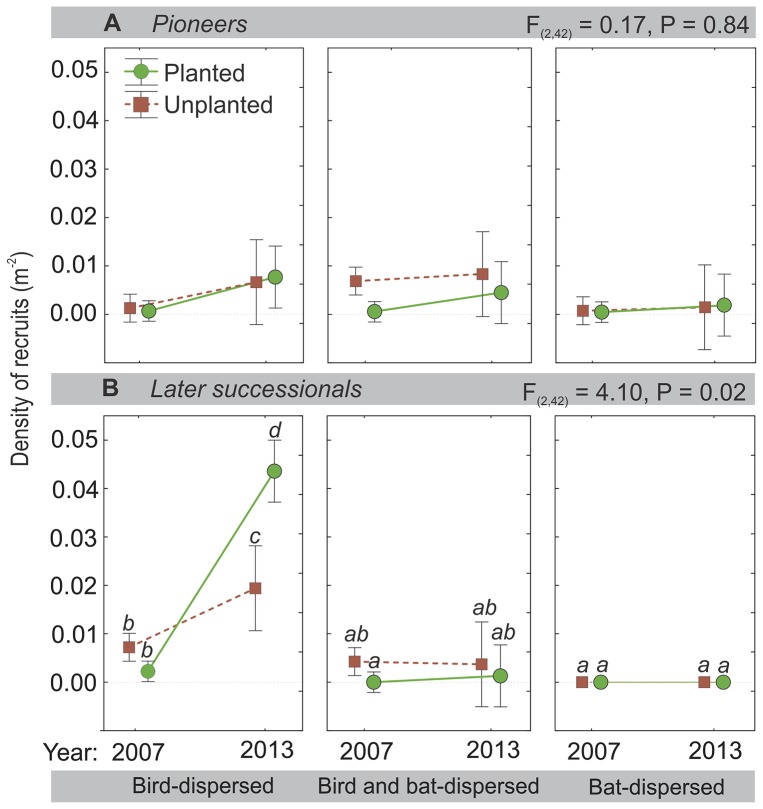
Net change in densities of recruited individuals by successional status and dispersal mode.Dispersal mode is indicated for (A) densities of pioneers and (B) densities of later-successional recruits. Blue circles indicate plantings, green squares unplanted controls. ANOVA statistics indicate disperser category by time interaction. Letters indicate differences between recruits in 2007 as compared with 2013 (Bonferroni adjustments, P<0.05). Shown are means and 95% confidence intervals.